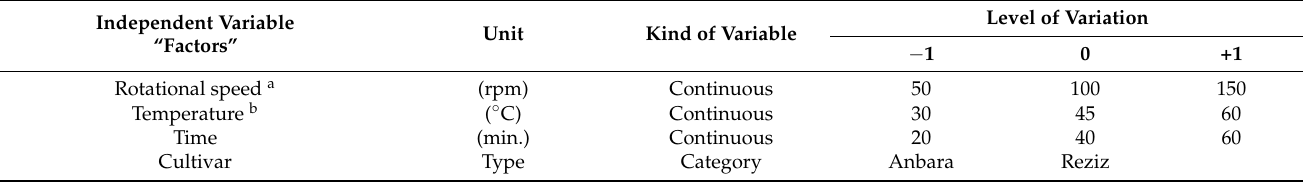
Table 1. Independent and dependent variables and their levels for the full factorial design of the WAE